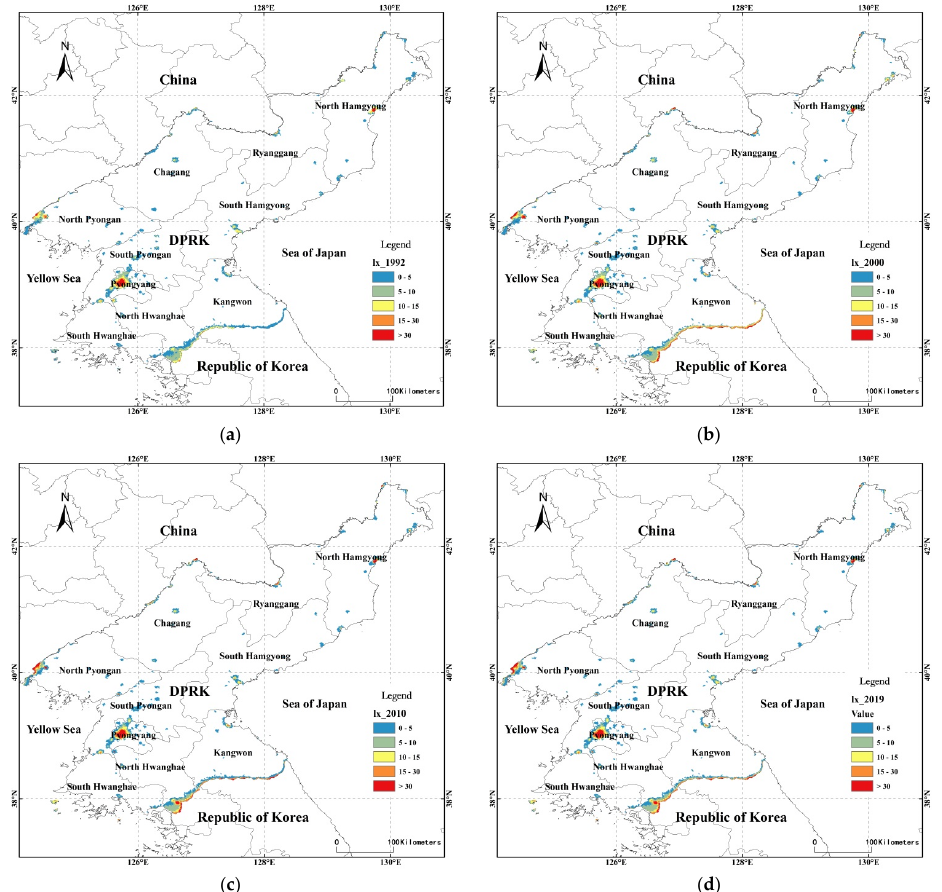
Figure 4. Urban spatial pattern in DPRK: spatial distribution of urban built-up areas in ( a ) 1992, ( b ) 2000, ( c ) 2010, and ( d ) 2019.